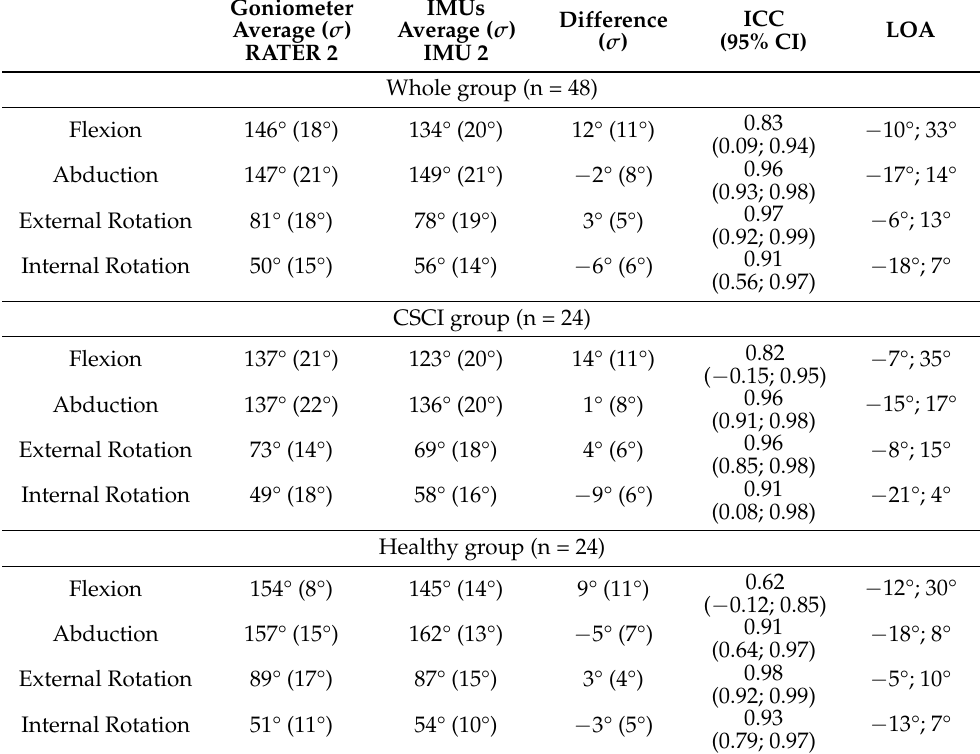
Table 8. Inter-instrument reliability indicators for goniometer and IMU measurements in CSCI patients and healthy group for RATER 2 and IMU